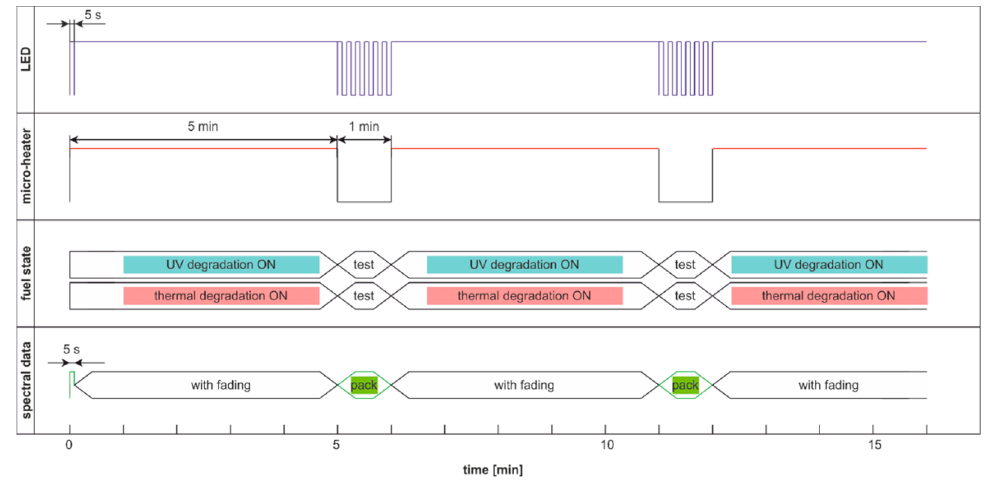
Figure 24. The modulated cycle of degradation and examination uses thermal and UV radiations for degradation and modulated UV for examination, named DME:UVonTon.